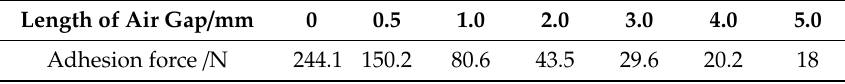
Table 4. The relation between the length of the gap and the adhesion force of a single magnetic